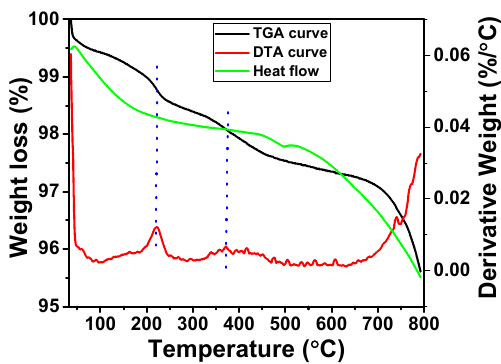
Figure 8. TGDTA curves of bio-reduced CuO NPs.